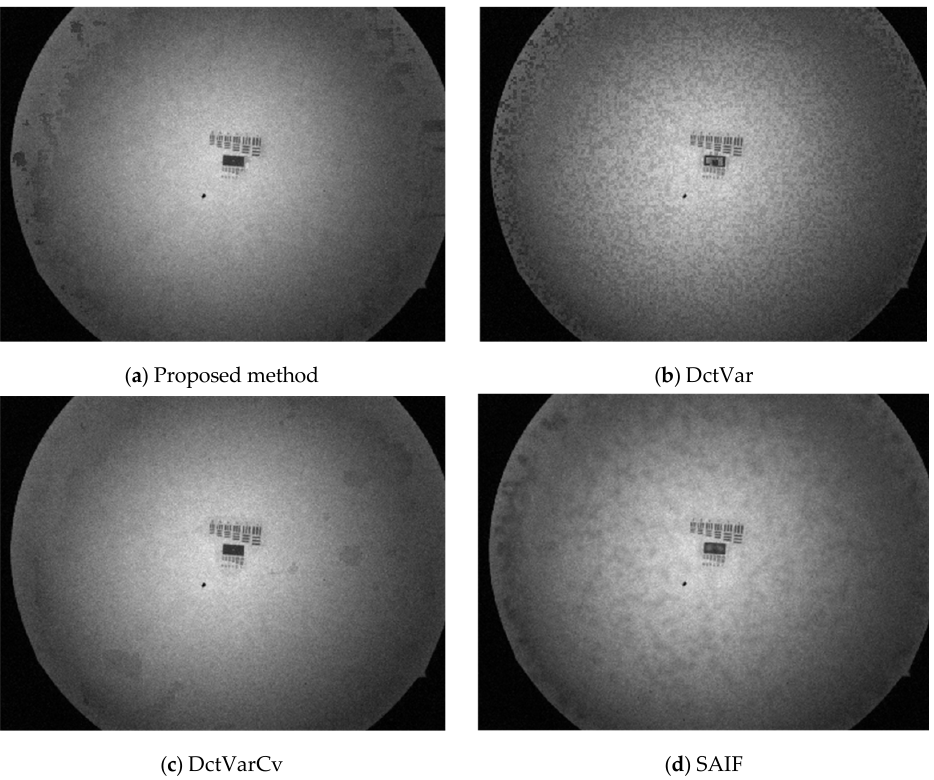
Figure 15. The fusion result of the NVG image (60 and 96 degrees).